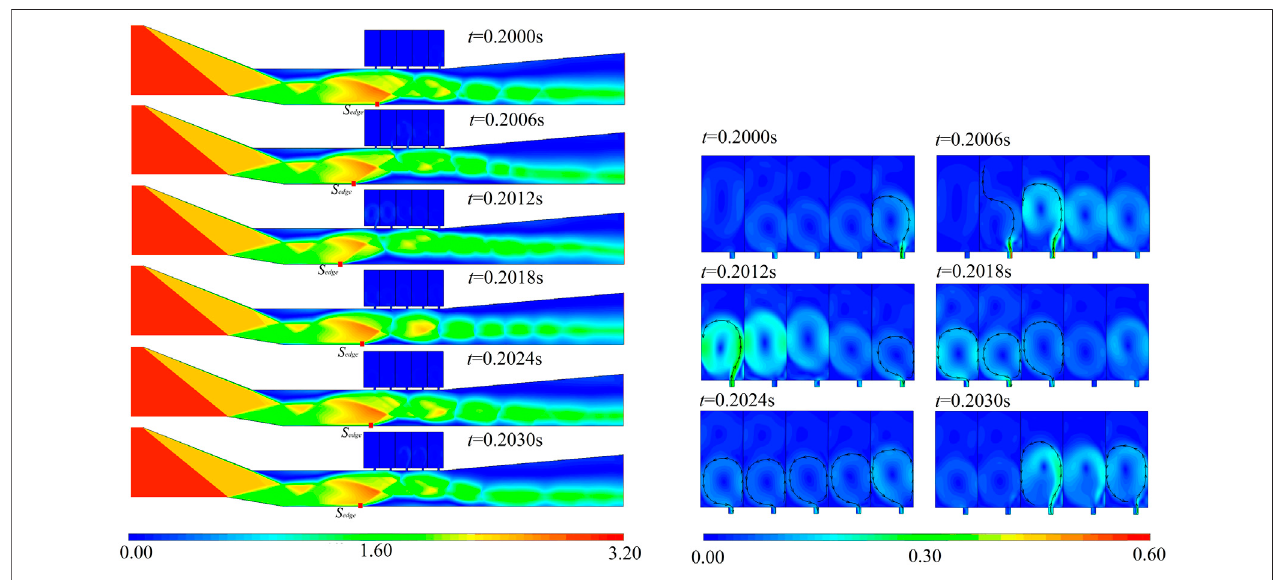
FIGURE 14 | Mach number contours of Model